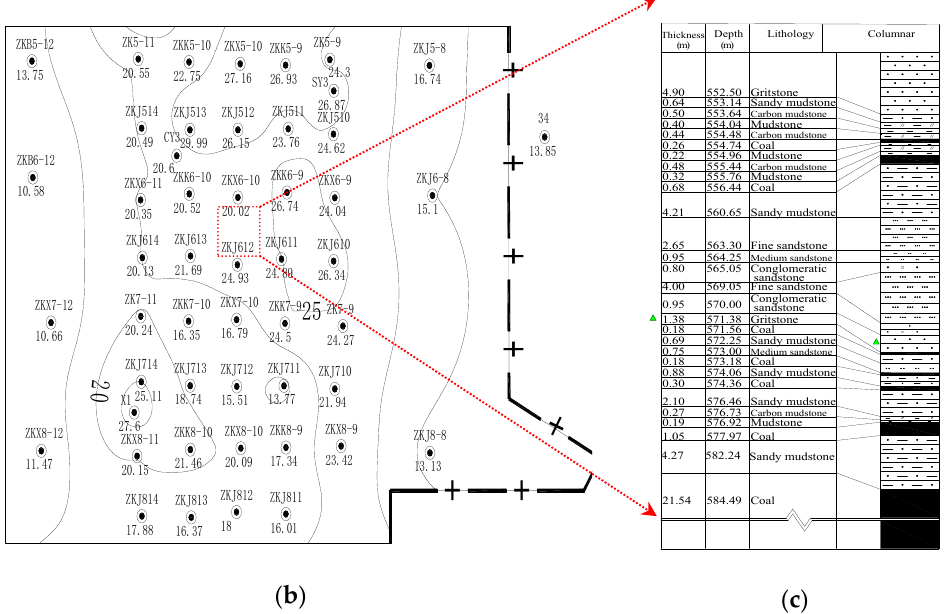
Figure 1. Geological situation of the study area. ( a ) Location of the study site. ( b ) Plan of drill hole distribution. ( c ) Stratigraphic column.